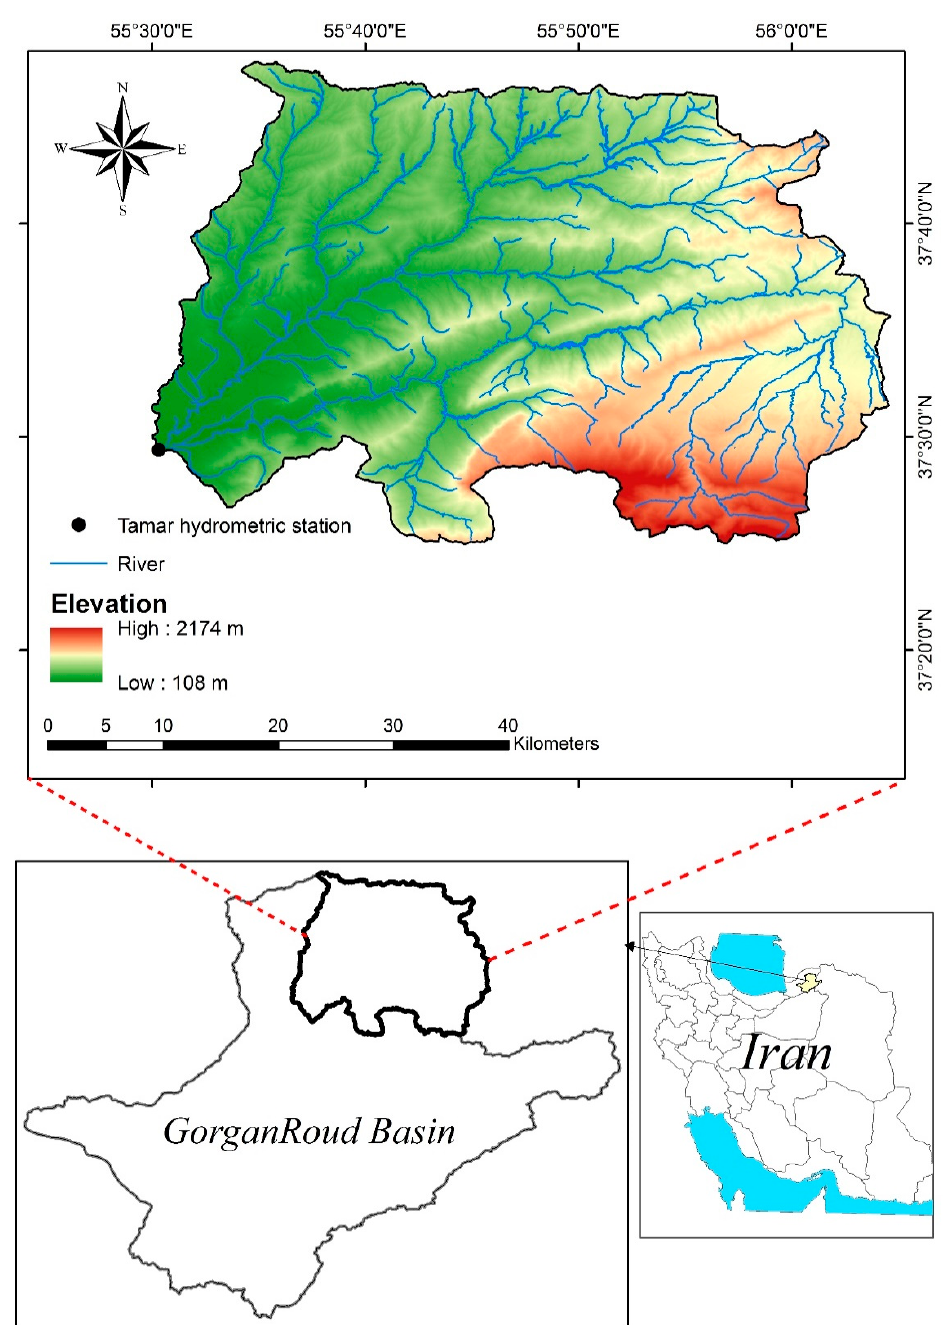
Figure 1. Location of the hydrometric station and drainage network map of Boostan dam watershed.